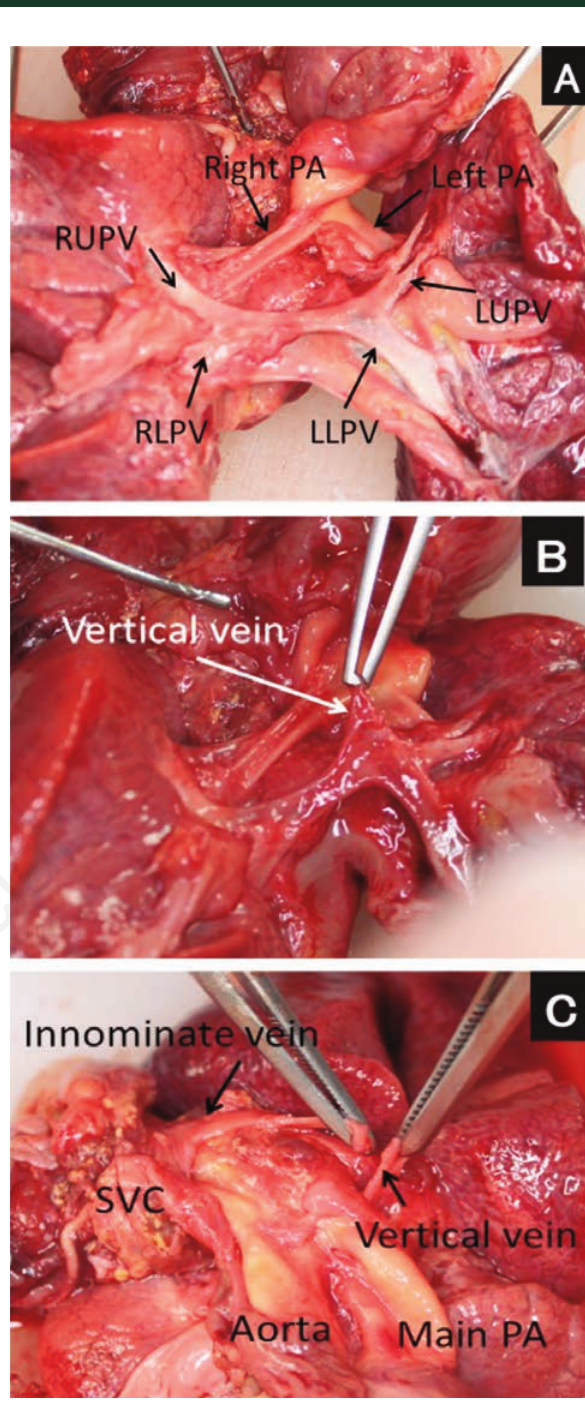
Figure 2. Macroscopic findings in the patient’s heart.Dorsal side of the heart. A) No connective veins to the left atrium, with all four pulmonary veins forming a small common chamber; B) Very narrow vertical vein found at the dorsal side of the left pul- monary artery; C) This vertical vein connected to the innominate vein. Abbreviations: LLPV, left lower pulmonary vein; LUPV, left upper pulmonary vein; PA, pulmonary artery; RLPV, right lower pulmonary vein; RUPV, right upper pulmonary vein; SVC, supe- rior vena